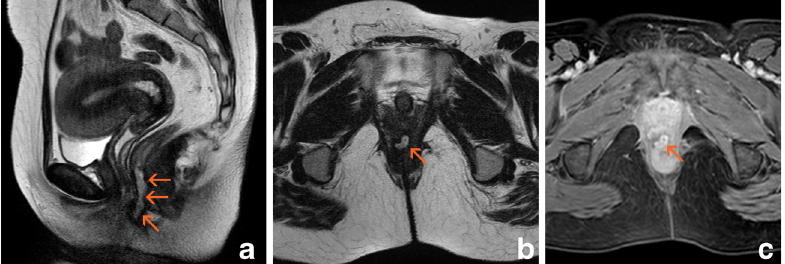
Fig.3 Anovaginal fistula. A thick gauge fistula exibited abscess formation involvingthe recto vaginal septum(arrows). a Sagittal T2-weightedimage. b Oblique-transverse T2-weighted image. c Post-gadolinium oblique-transverse fat-supressed gradient echo T1-weighted image